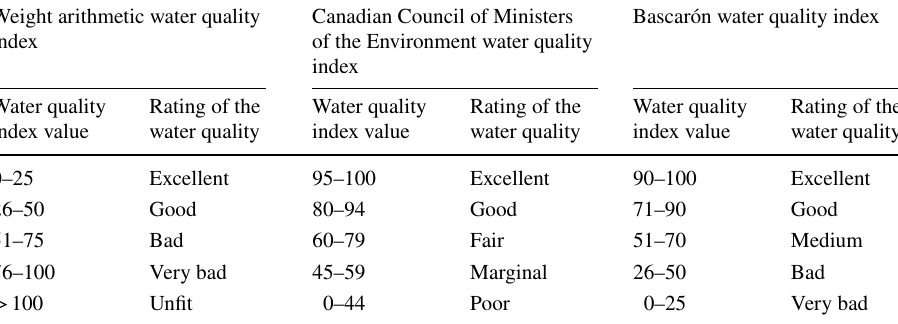
Table 1 Water quality indices and